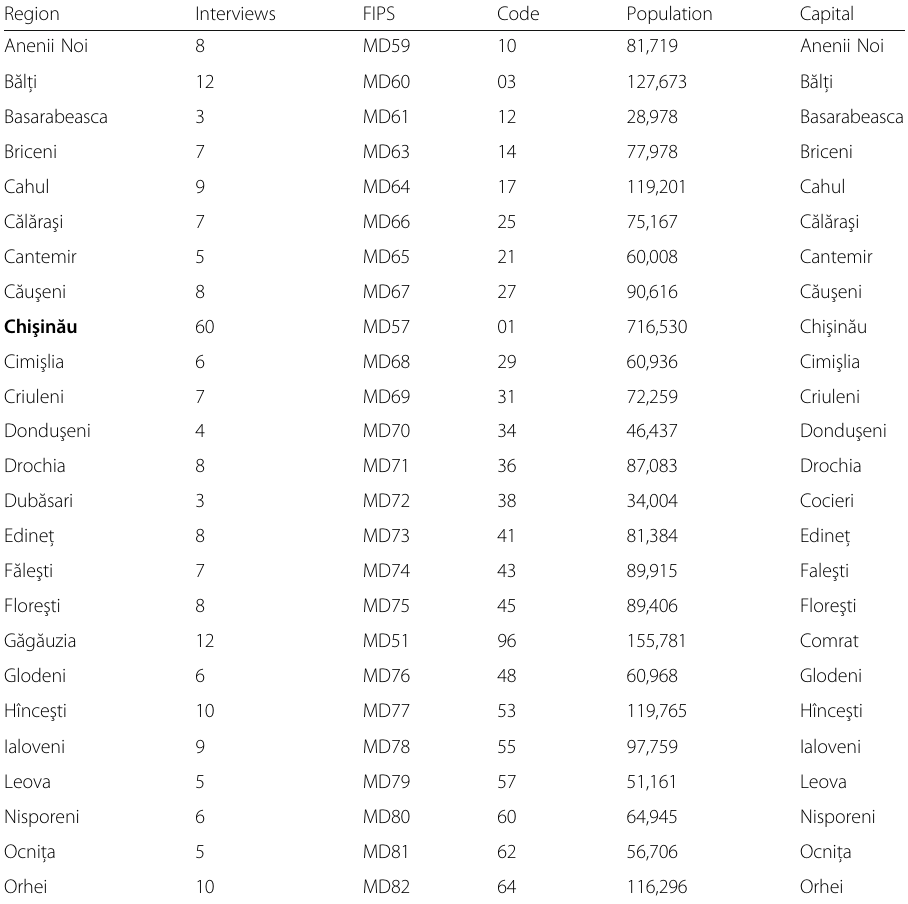
Table 1 The number of interviews conducted in Moldovan regions